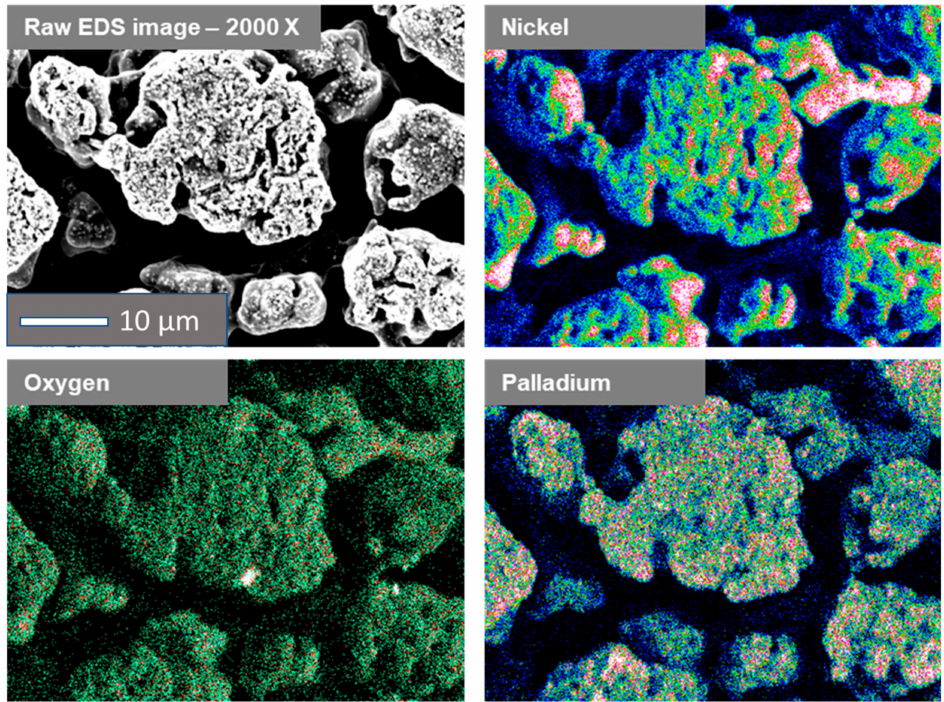
Figure 6. Mapping analysis for a porous Ni electrode decorated by Pd ions in the galvanic displace- ment process after 3600